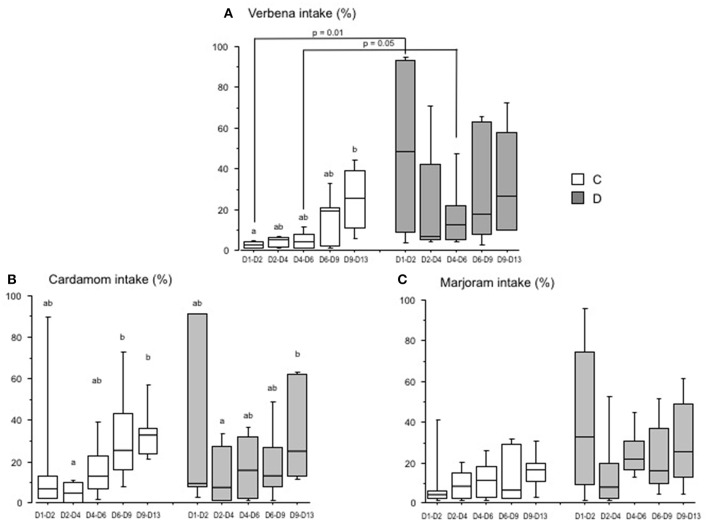
Essential oil intake by chicks over time (Experiment 1). Chicks were either directly placed in pens (C group; white) or delayed for 24 h (D group; gray). The histograms show the box-plots and whiskers of EO intake (EO/(water + EO), %) for each group, verbena (A), cardamom (B), and marjoram (C). Different letters indicate significant differences in EO intake between periods of measurement for each group of chicks (Dunn test). The p-values indicate significant differences between the C and D groups within each period (Mann-Whitney test).